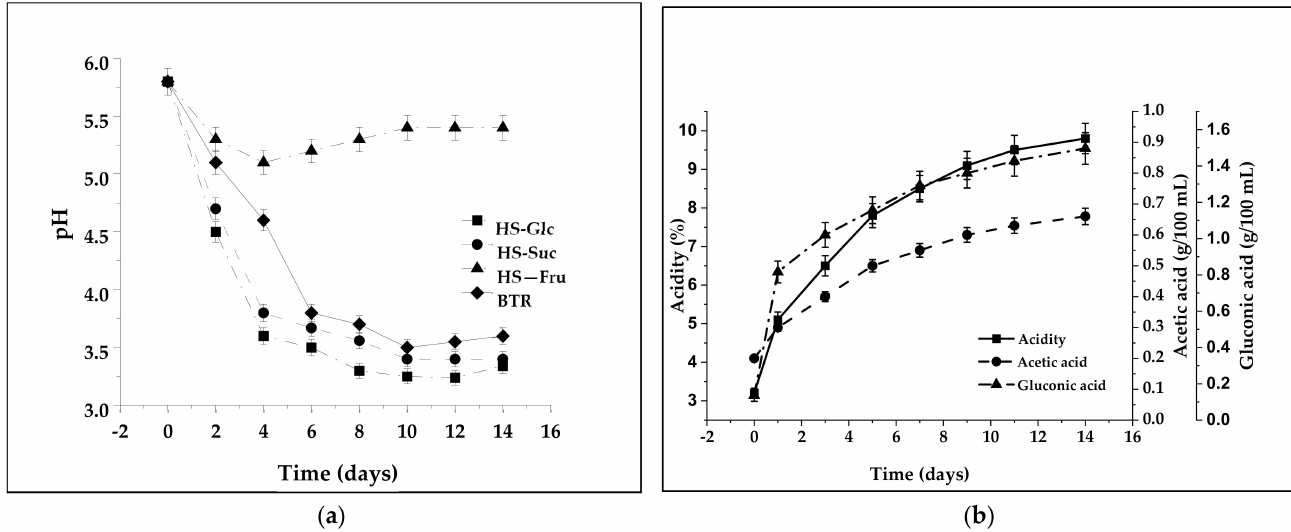
Figure 1. Values of pH and acidity during kombucha fermentation: ( a ) changes in pH as a function of the carbon source; ( b ) changes in acidity and acetic acid and gluconic acid concentrations during kombucha fermentation in beetroot (BTR)